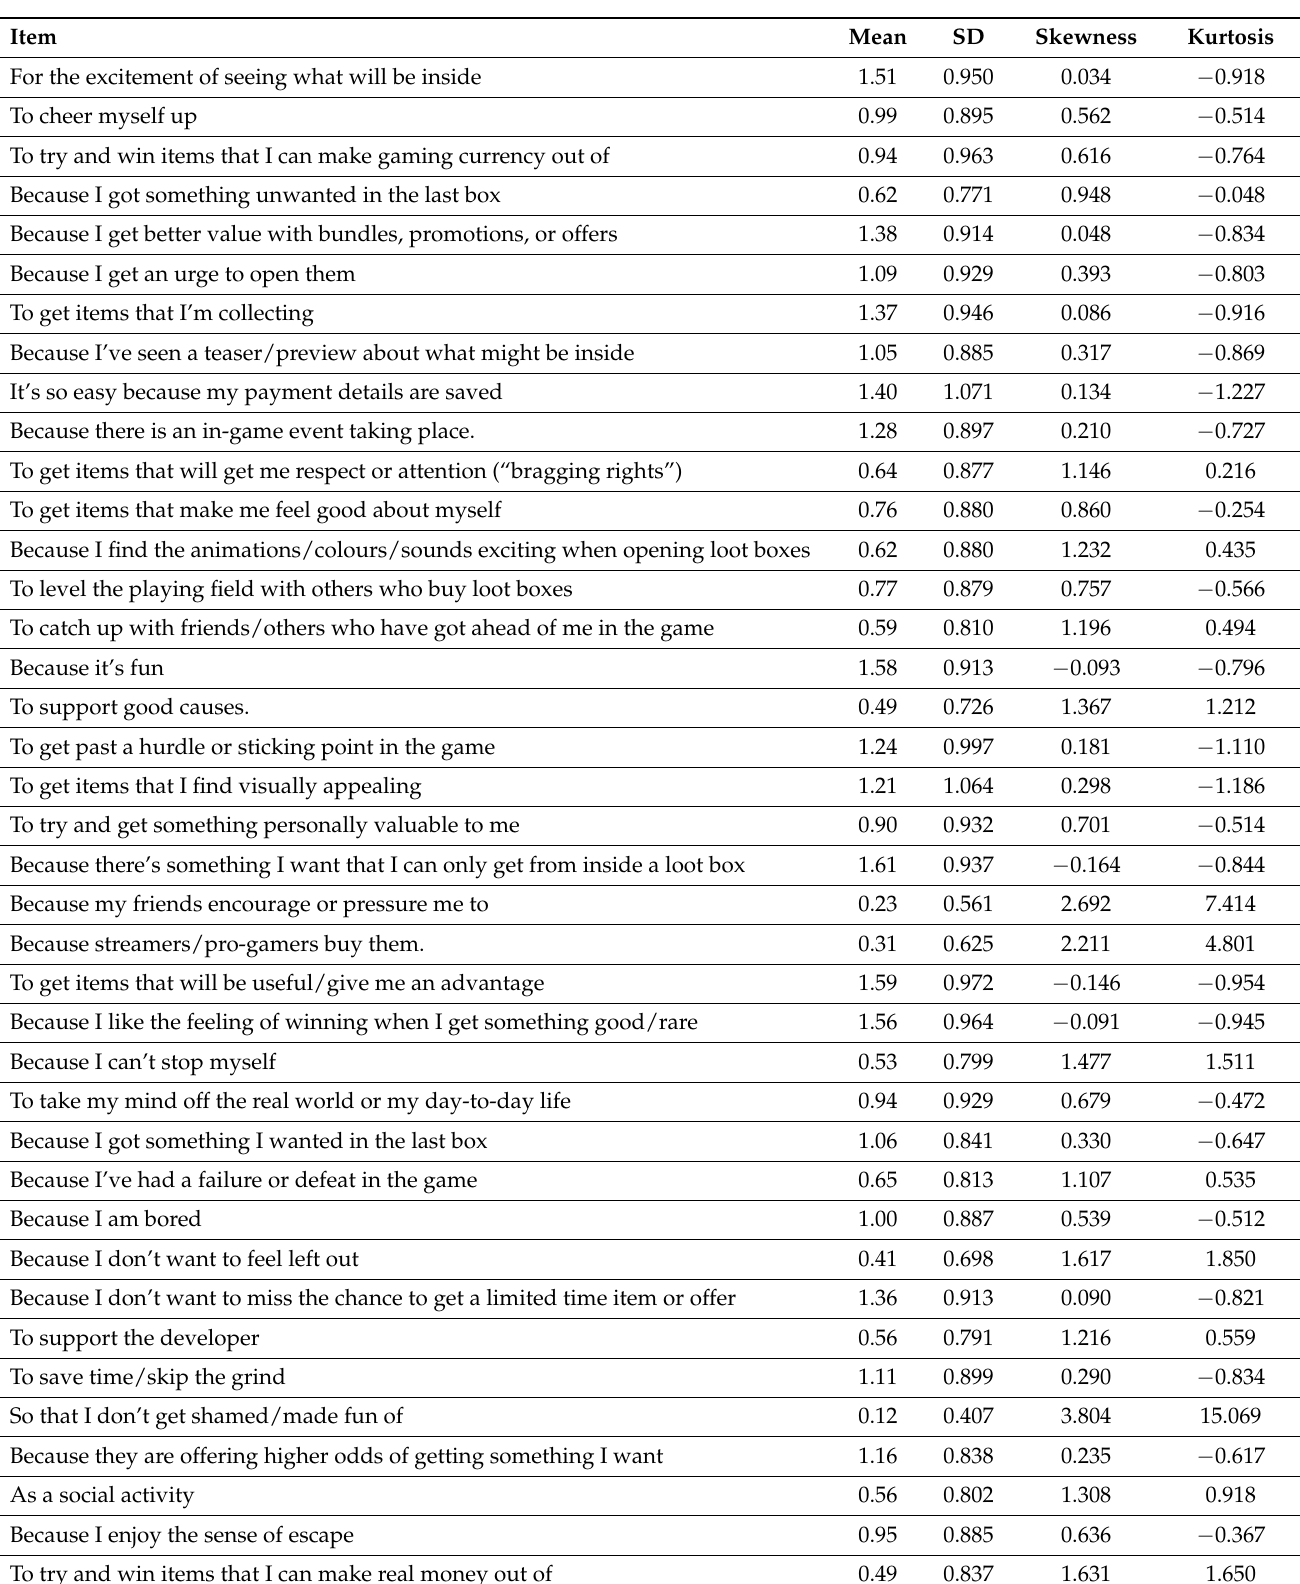
Table 2. Descriptive statistics for the 39 candidate